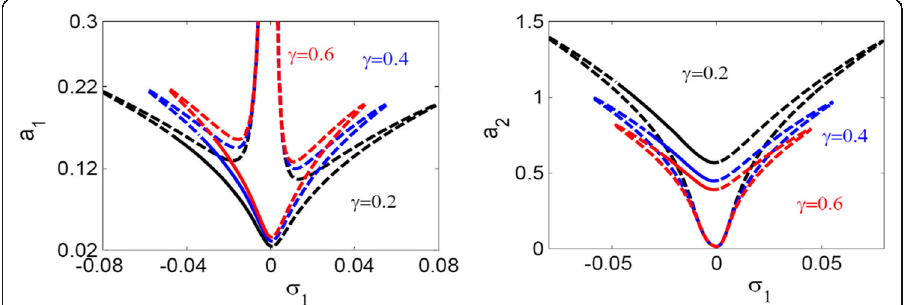
Fig. 5 Effects of control signal gain